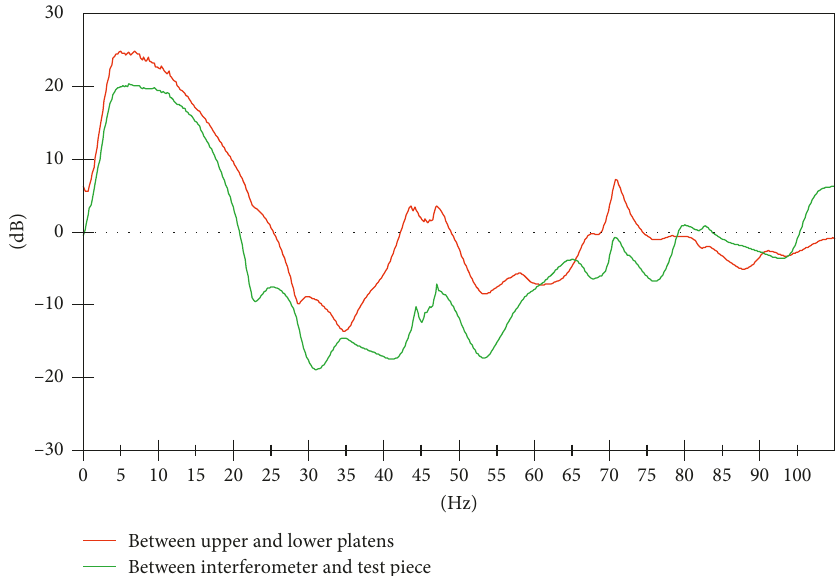
Figure 14: Comparison of the two transmissibility functions in X direction.